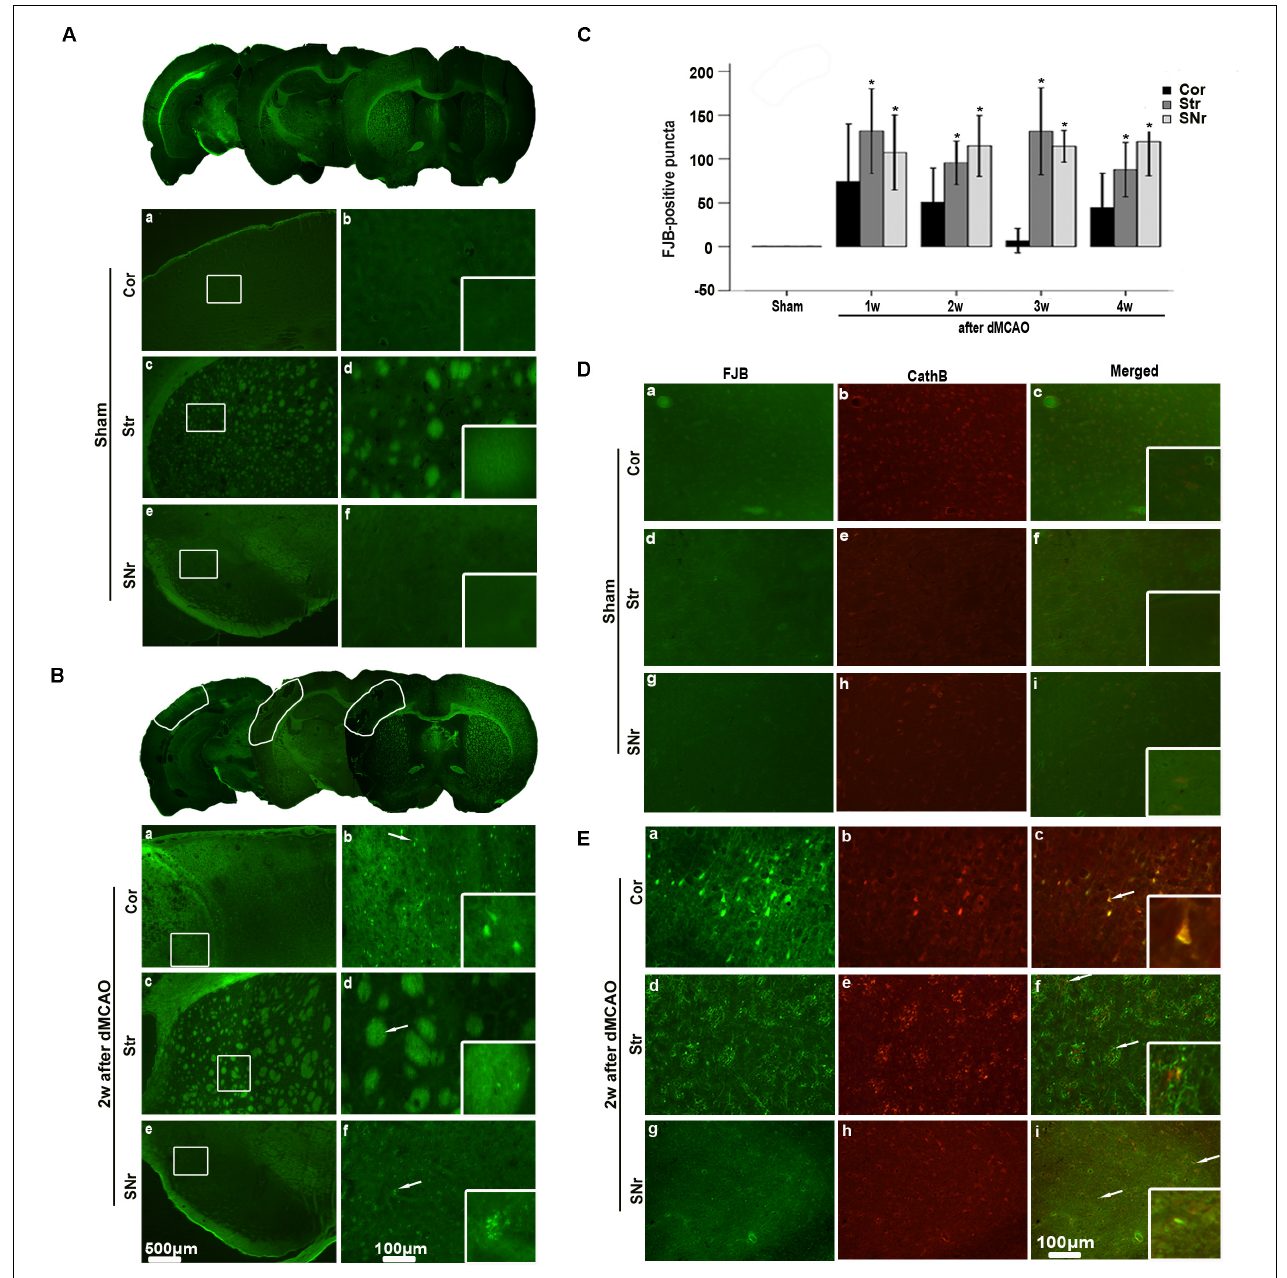
FIGURE 2 | Secondary degeneration in the ipsilateral SNr after dMCAO in rats. (A,B) Representative microphotographs of FJB staining in the ipsilateral Cor, Str, SNr at sham operation (A , a–f) and at 2 weeks after dMCAO (B , a–f) . The panels at the bottom right corner are magnified from the outlined territory in the ipsilateral cortex, striatum, and SNr. Scale bar: b , d , f : 100 µ m; a , c , e : 500 µ m. (C) Quantitative analyses of FJB positive substance in the ipsilateral SNr at 1–4 weeks after dMCAO ( n = 6, 6, 7, and 7, respectively) or sham operation ( n = 6). Each bar represents the mean ± SD. ∗ p < 0.05 versus sham-operated group. (D,E) Colocalization of CathB immunoreactive punctate and FJB positive substances at sham operation or after dMCAO. Representative images of fluorescent double-staining of CathB (red) and FJB positive substances (green) in the ipsilateral Cor, Str, SNr at sham-operated group and at 2 weeks after dMCAO. Cor, cotrex; Str, striatum; SNr, substantia nigra pars reticulata; Scale bar, 100 µ m; w,